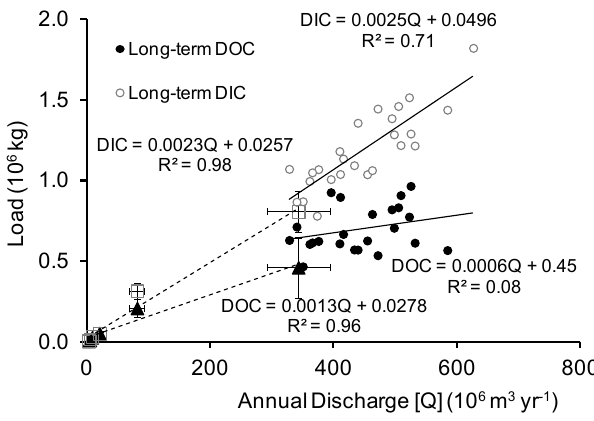
Fig. 6. Annual DOC and DIC loads in relation to total annual stream flow for stream 6 (Abiskojokka) based on available long-term data (here, filled circles are DOC loads and open circles are DIC loads) in comparison to the range of values observed for the six catchments considered in this study (here, filled triangles are DOC and open triangle are DIC). Solid trend lines are fit to the long-term data for stream 6 while dashed trend lines are fit to the annual data for the six